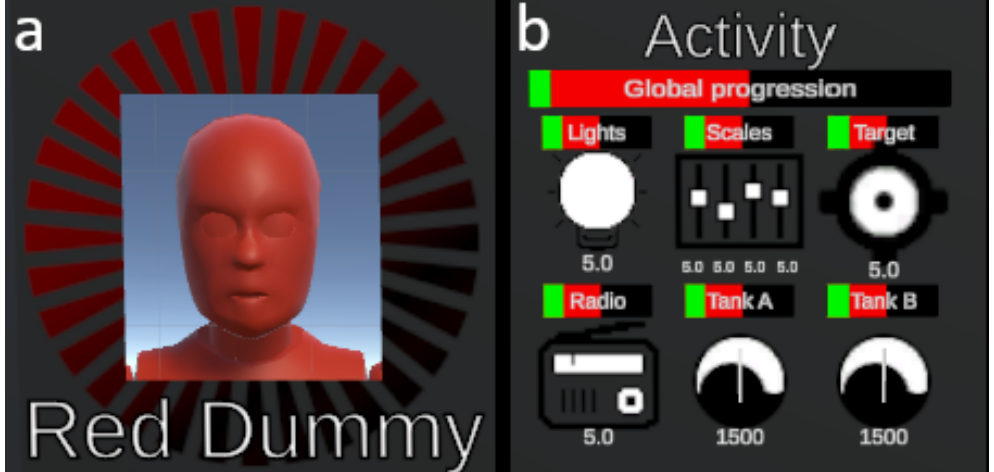
Figure 2. Indicators divided into two groups: ( a ) identification and ( b ) task